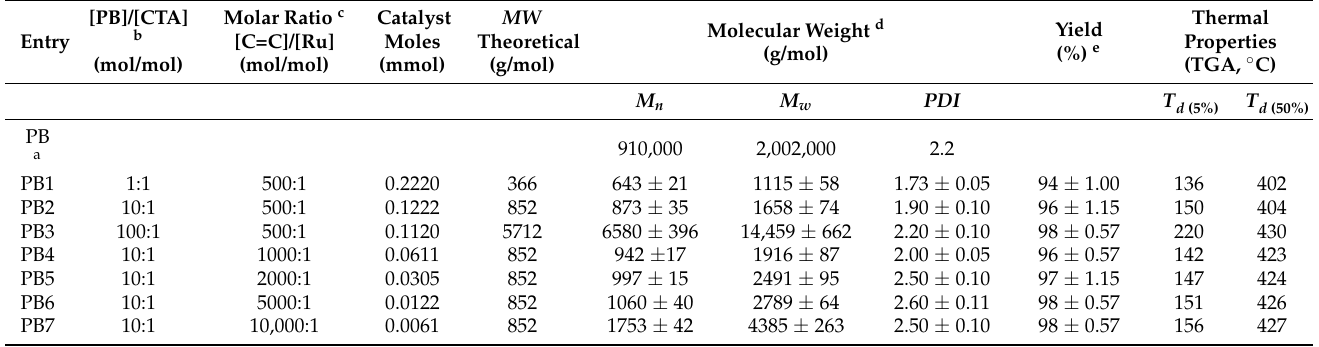
Table 2. Catalyst optimization used for the synthesis of biobased HTPB via metathesis degradation of